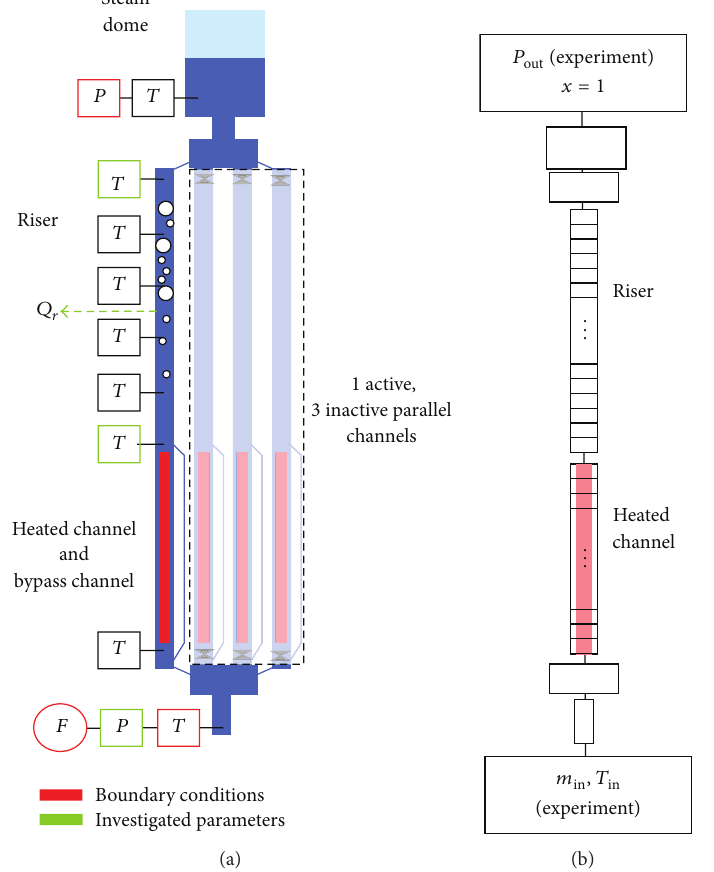
Figure 5: CIRCUS-IV single channel test section: (a) scheme and (b) RELAP5